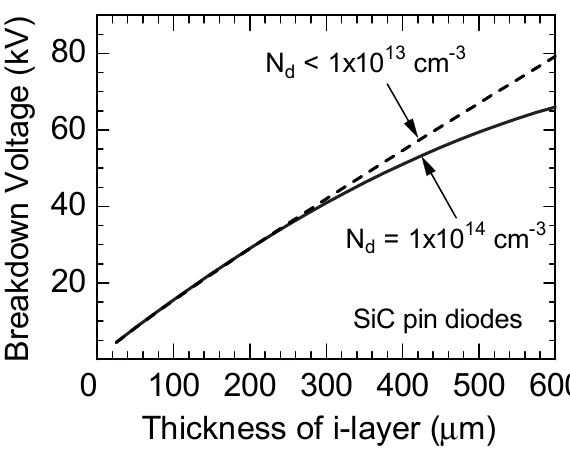
Figure 2. Dependence of breakdown voltage for SiC pin diodes on i-layer thickness. The solid and dashed lines denote the results for the i-layer doping concentration of 1 × 10 14 cm − 3 and <1 × 10 13 cm − 3 , respectively.